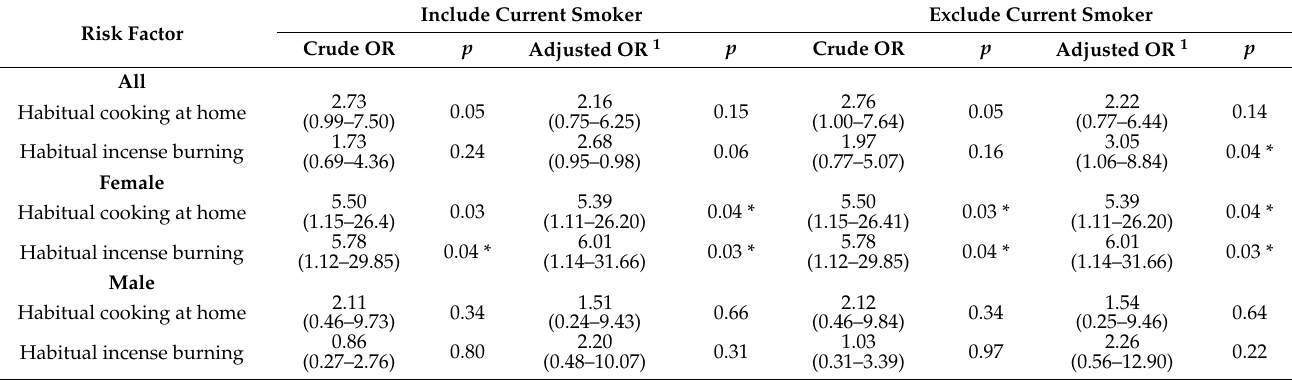
Table 2. Indoor air pollutants and the risk of lung